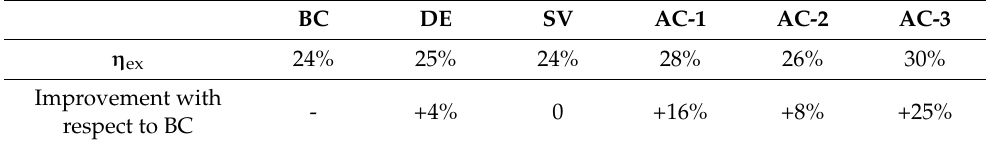
Table 2. Second law efficiency and improvement with respect to the base case for the several